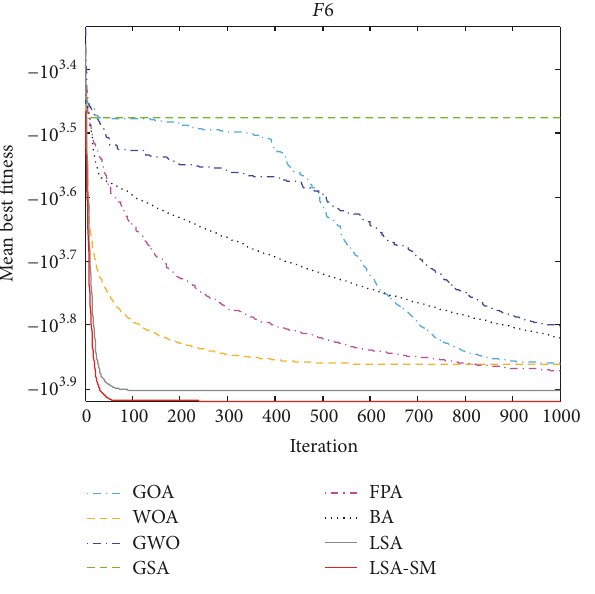
Figure 10: 𝐷 = 30 , convergence curves for 𝑓 06 .